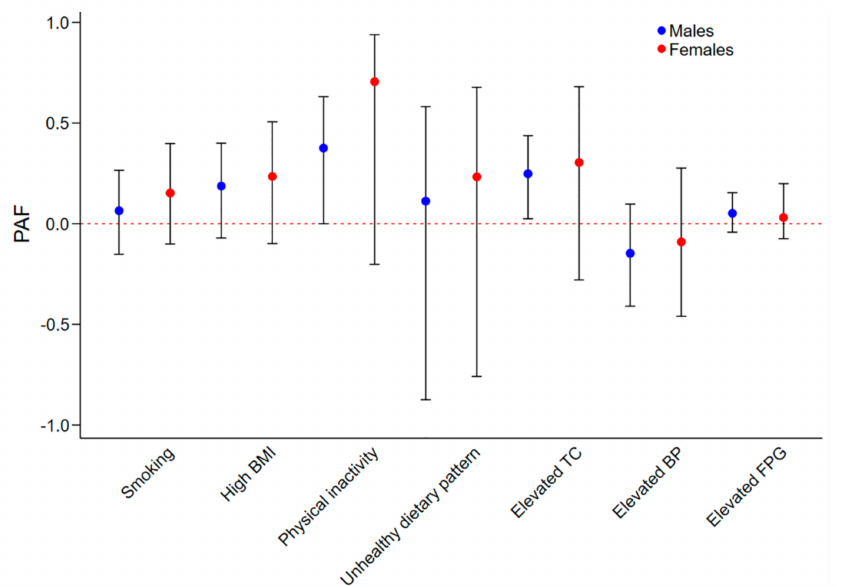
Figure 1. Adjusted PAFs of CVH metrics to IHD prevalence, stratified by sex. Abbreviations: PAF, population attributable fraction; TC, total cholesterol; BP, blood pressure; FPG, fasting plasma glucose; CVH, cardiovascular health; IHD, ischemic heart disease.